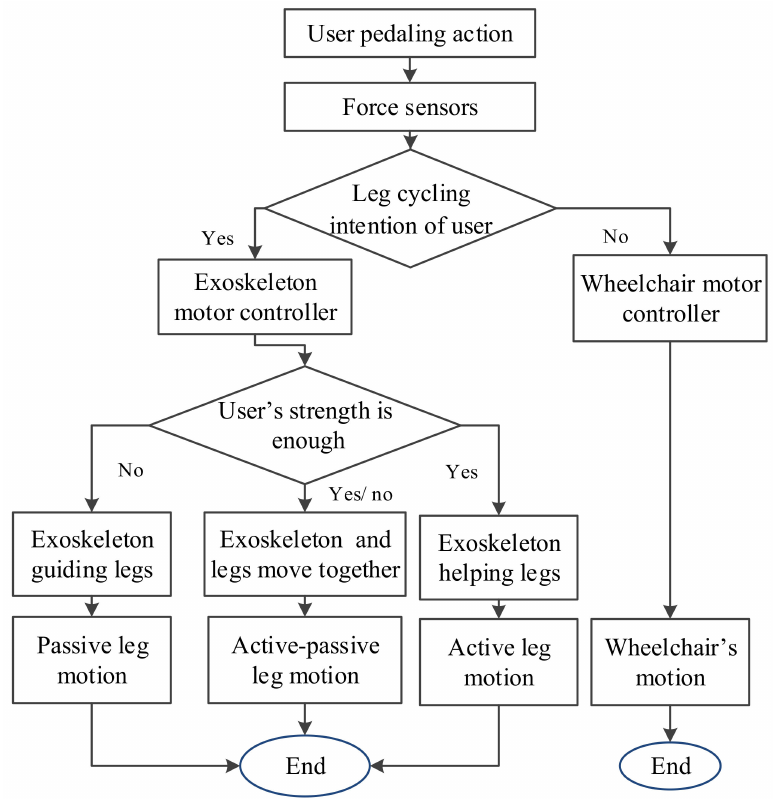
Figure 3. Control strategy flowchart for the wheelchair robot in Figures 1 and